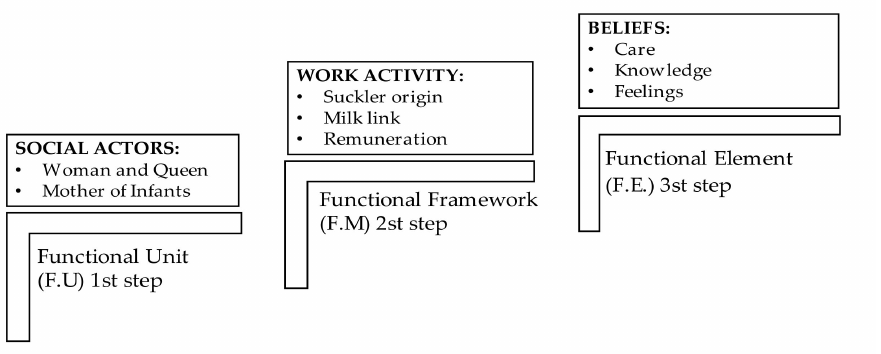
Figure 1. Theoretical dialectical structural model of care (DSMC) model: application of structures. Source: authors’ own